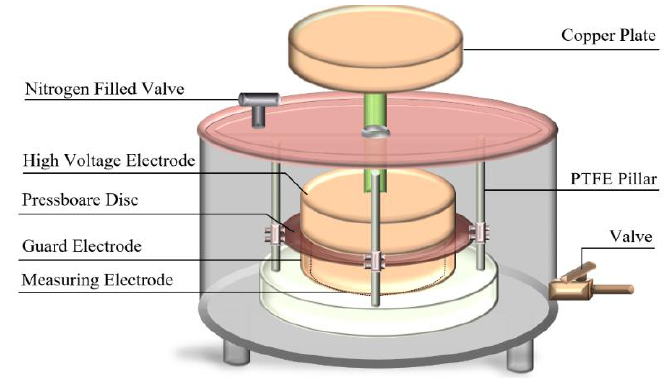
Figure 2. The three-electrode test cell.